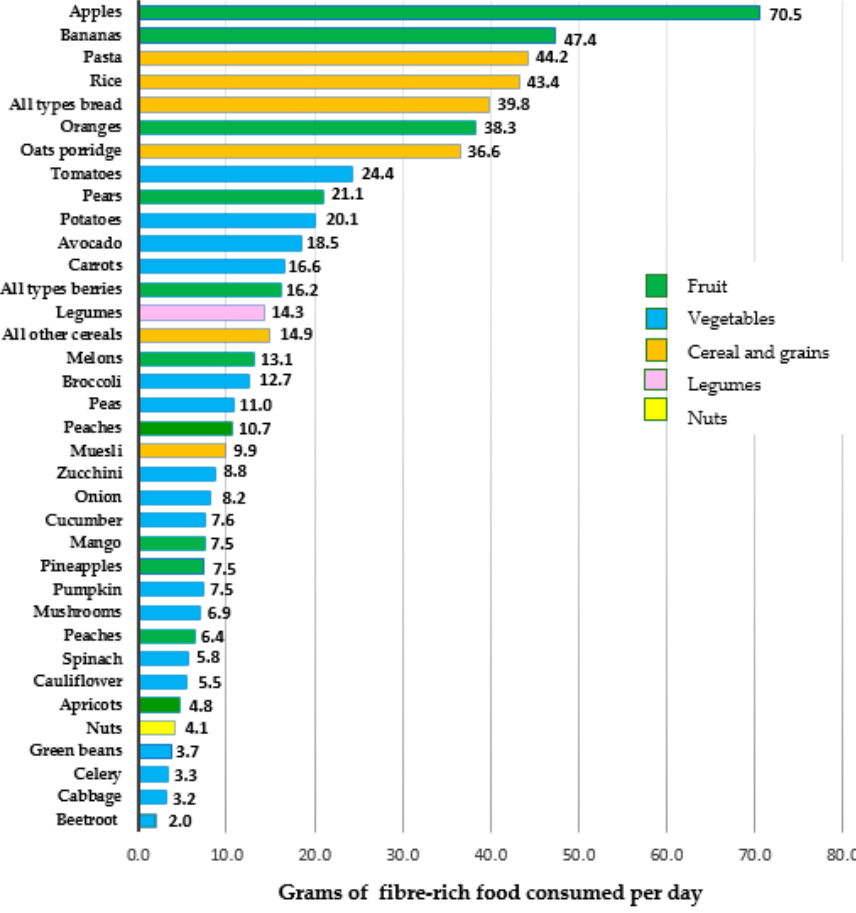
Figure 2. Fiber-rich foods (grams/day) consumed by women during late pregnancy. Table 2. Number (and %) of women meeting the Australian Dietary Guidelines daily recommended fruit and vegetable consumption. Food